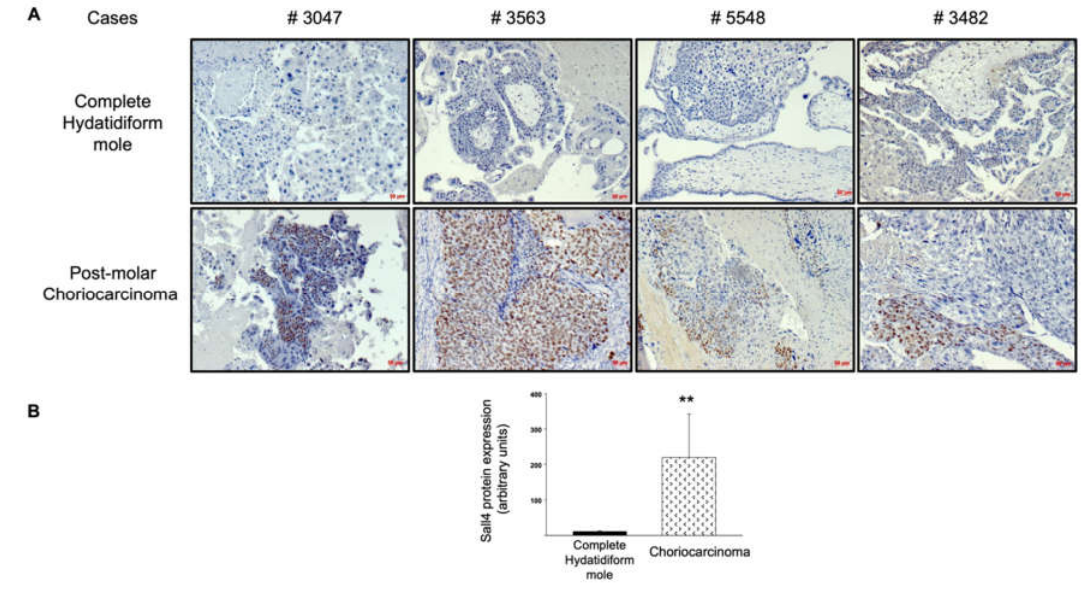
Figure 3. SALL4 protein expression in complete mole and postmolar choriocarcinoma. ( A ) Comparison of SALL4 immunostaining on paired samples. ( B ) Quantitative assessment of SALL4 expression via immunohistochemistry. **p < 0.01 ± SEM. Scale bar = 50 µ m.